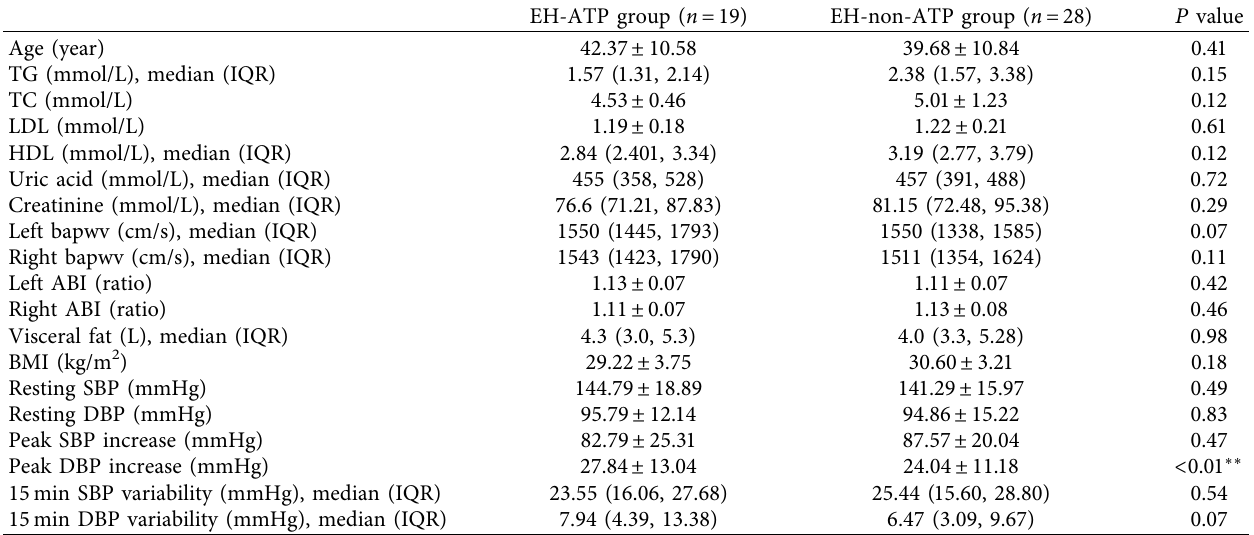
Table 4: Comparison of clinical data between EH-ATP group and EH-non-ATP